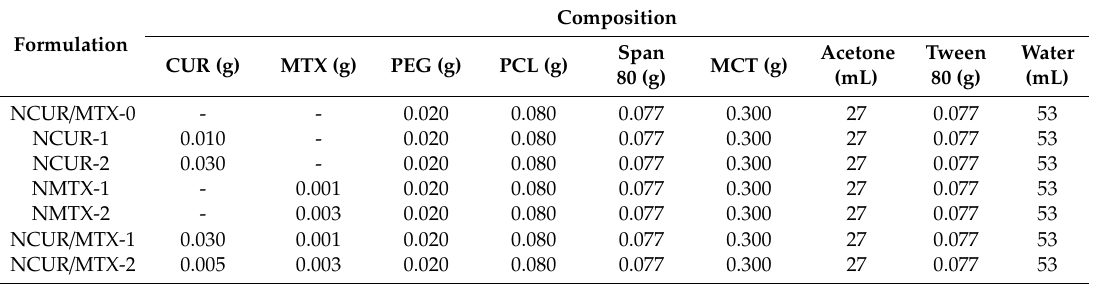
Table 3. Composition of polymeric nanocapsules containing curcumin (CUR) and / or methotrexate (MTX).